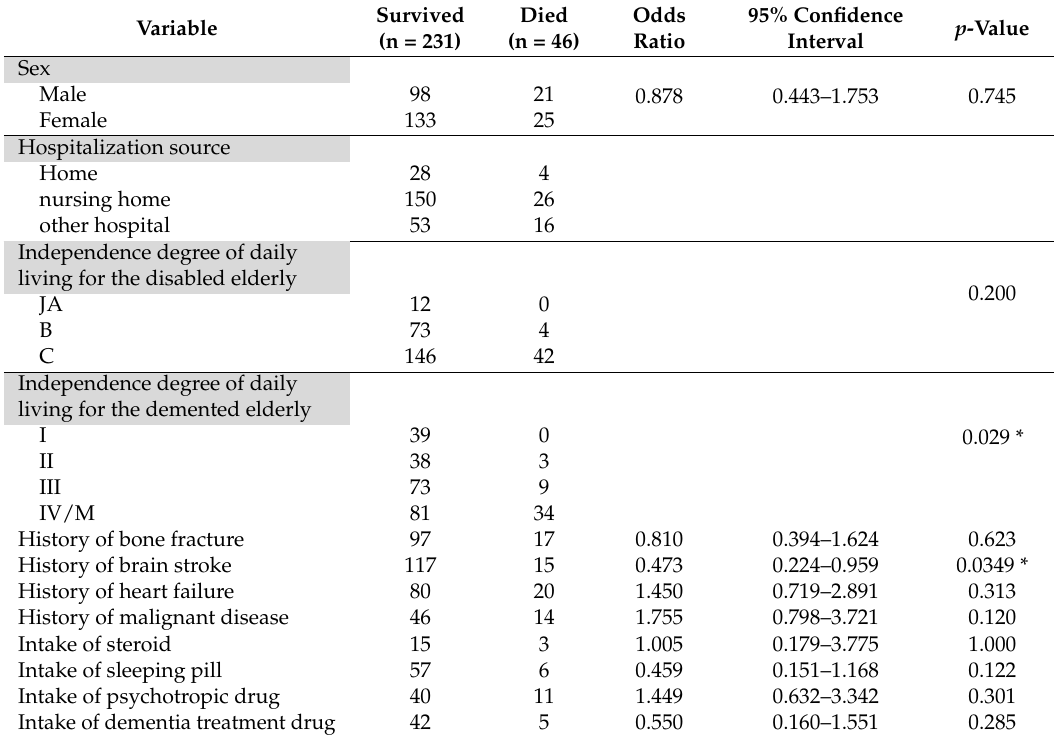
Table 3. Characteristics of the participants of this study (univariate analysis).